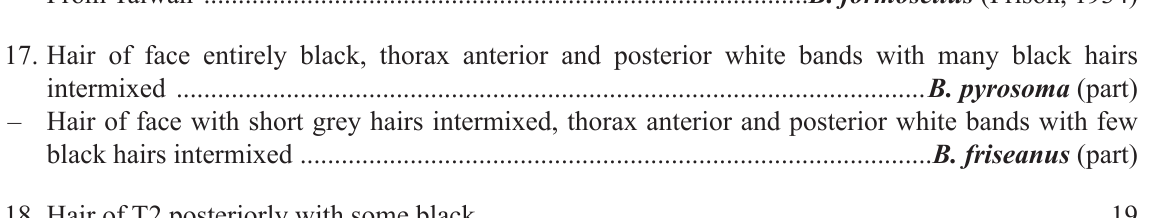
– Hair of T2 posteriorly entirely either white or cream or yellow .................................................... 20 19. Hair of T1 with at least a few cream or yellow hairs, pale bands of thoracic dorsum either cream or – Hair of T1 entirely black, pale bands of thoracic dorsum white ......................... B. eriophorus (part) 20. Hindleg basitarsus broad (length 3 × greatest breadth) with the distal posterior corner broadly angled (nearly 90°), outer surface with the short hairs golden, hair of the scutellum with few or no black – Hindleg basitarsus narrow (length 4 × greatest breadth) with the distal posterior corner sharply angled (nearly 45°), outer surface with the short hairs predominantly black, hair of the scutellum